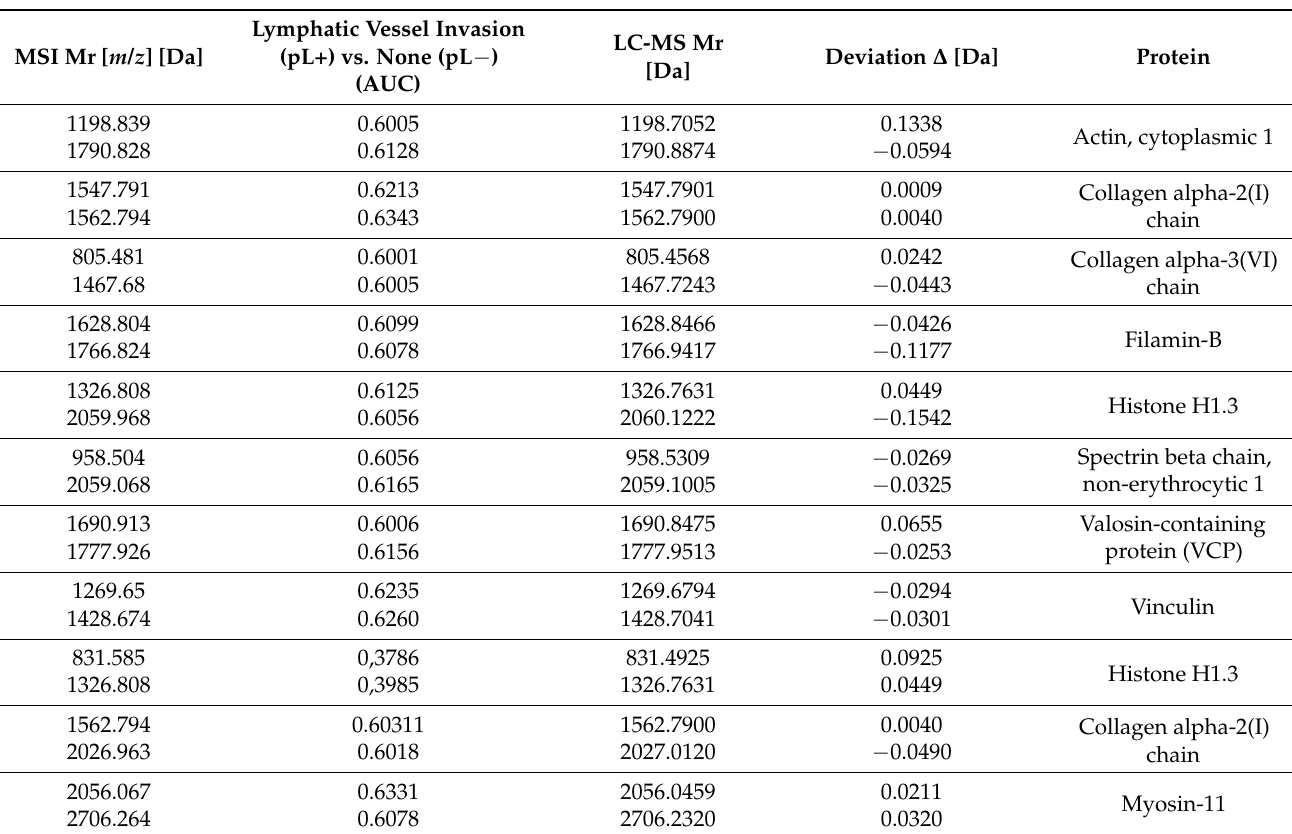
Table 2. Differential intensity distributions of peptides (MALDI-MSI) and their corresponding proteins in tissue sections from pancreatic